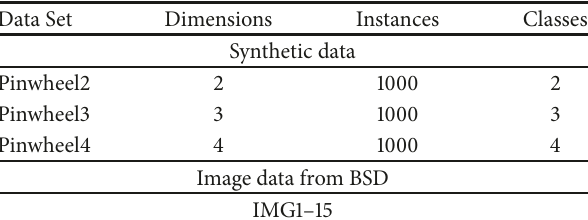
Table 2: Datasets used for the experiments.